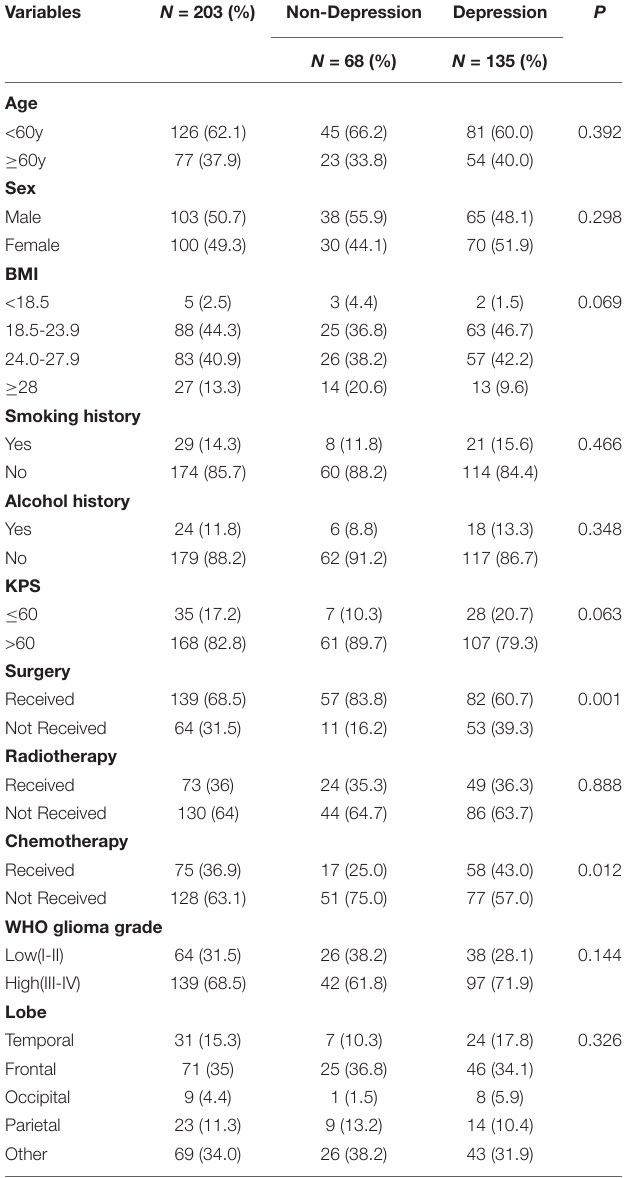
TABLE 1 | Comparison of demographic and clinical characteristics between glioma patients with and without depression. Variables N = 203 (%)